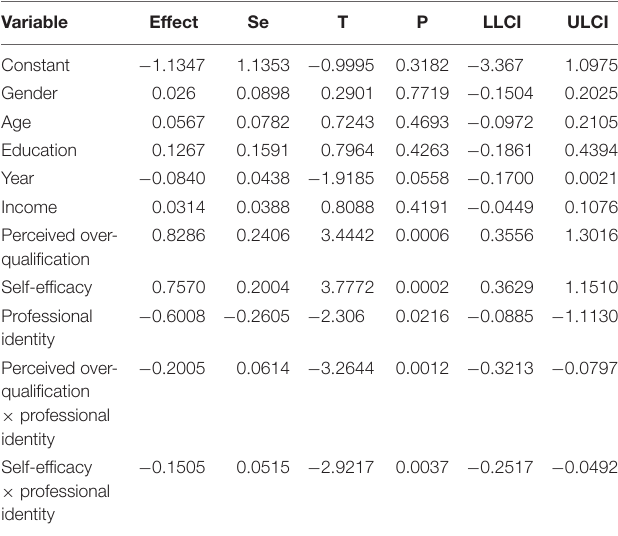
TABLE 8 | Result for self-test analysis.